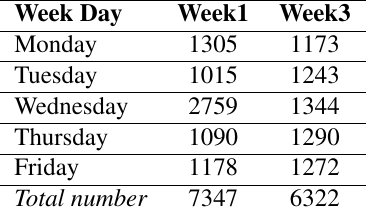
Table 1. The number of false alarms in Week1 and Week3.